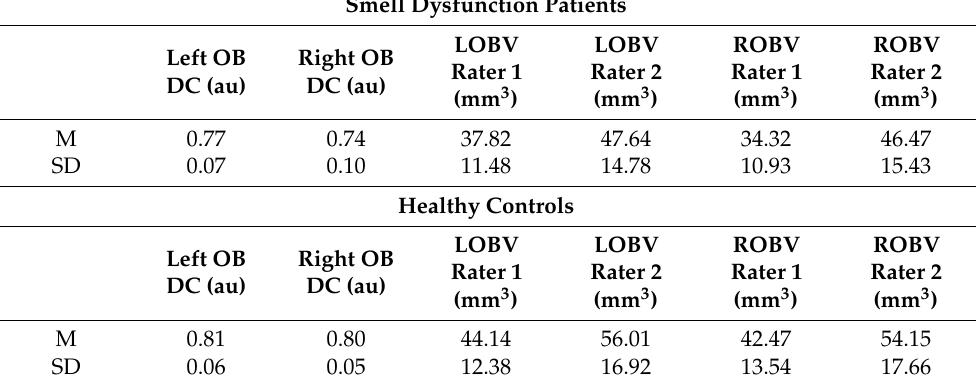
Table 2. The table shows convergence of manual segmentations performed by two raters, based on DC and left and right olfactory bulb volume (LOBV and ROBV) for each rater, respectively. The unit (au) means arbitrary